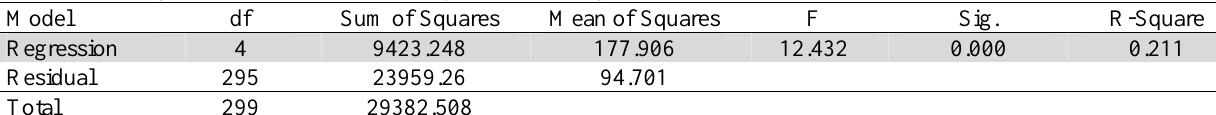
The summary of ANOVA test on regression analysis Model